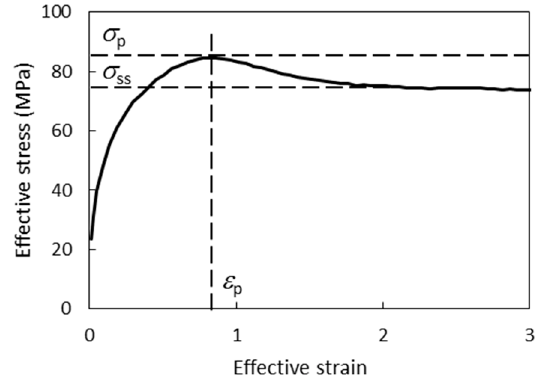
Figure 1. Hot torsion flow curve determined at 1000 ◦ C and strain rate 1 s − 1 .